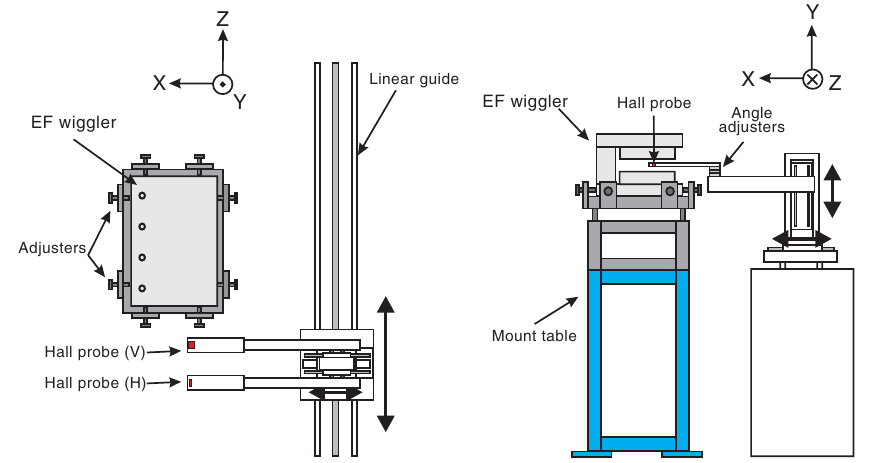
FIG. 4. (Color) Schematic drawing of the magnetic field measurement system for the EF wiggler. Left is a top view and right is a side view. Each Hall probe is installed at the tip of an arm equipped with two tilt stages and a horizontal rotation stage for adjusting the orientation of the Hall probe. The two arms with the Hall probes are mounted on a 3-axis linear stage with two vertical linear stages for adjustment of relative